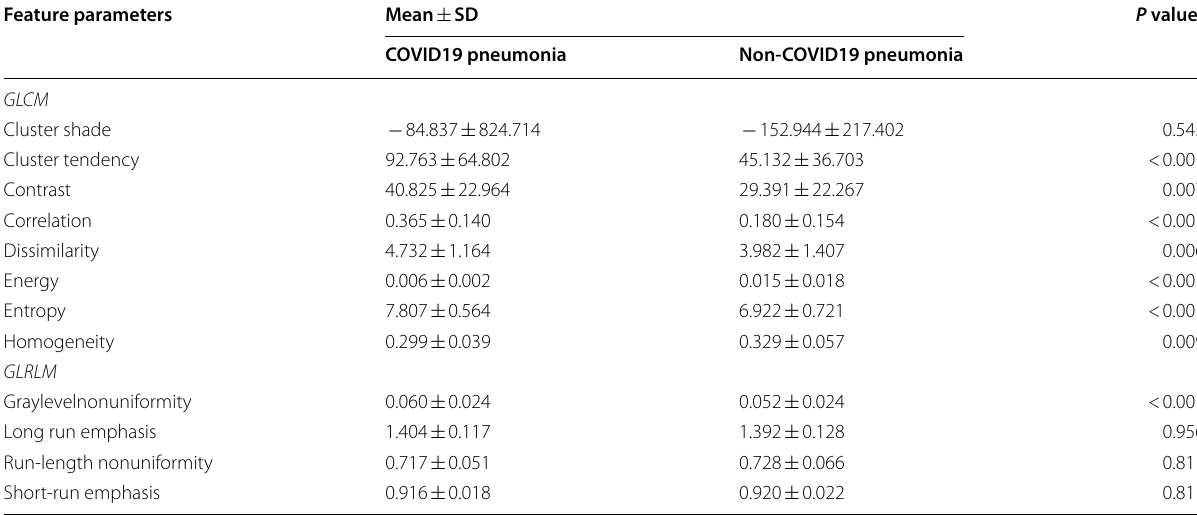
Table 2 Feature parameters in association with COVID19 status Feature